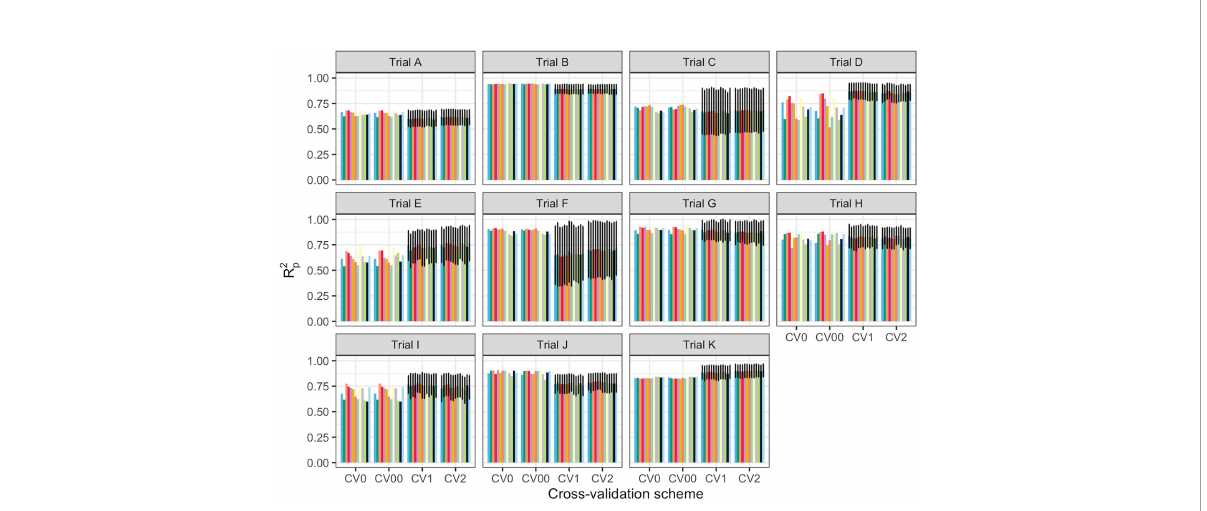
FIGURE 5 Prediction of cassava root starch content using four cross-validation schemes and the partial least squares regression algorithm. The x-axis displays the four cross-validation (CV) schemes. The y-axis shows the squared Pearson ’ s correlation between predicted and observed values in the test set (R 2 p ) for 50 iterations of the waves prediction pipeline with no spectral pretreatment. The colors represent the various pretreatments. CV0 indicates leave-one-trial-out CV and CV00 indicates that there was no overlap between genotypes and environments in the training and test sets. CV1 indicates overlap in the environment but not genotypes between the training and test sets. CV2 indicates an overlap of both genotypes and environments in the training and test sets. However, genotypes with multiple replicates within a trial were sorted together in all cases. Error bars show the standard deviation for schemes with subsampling (CV1 and CV2). As no subsampling occurred in either the CV0 or CV00 schemes, the standard deviation was not calculated and, hence, no error bars are